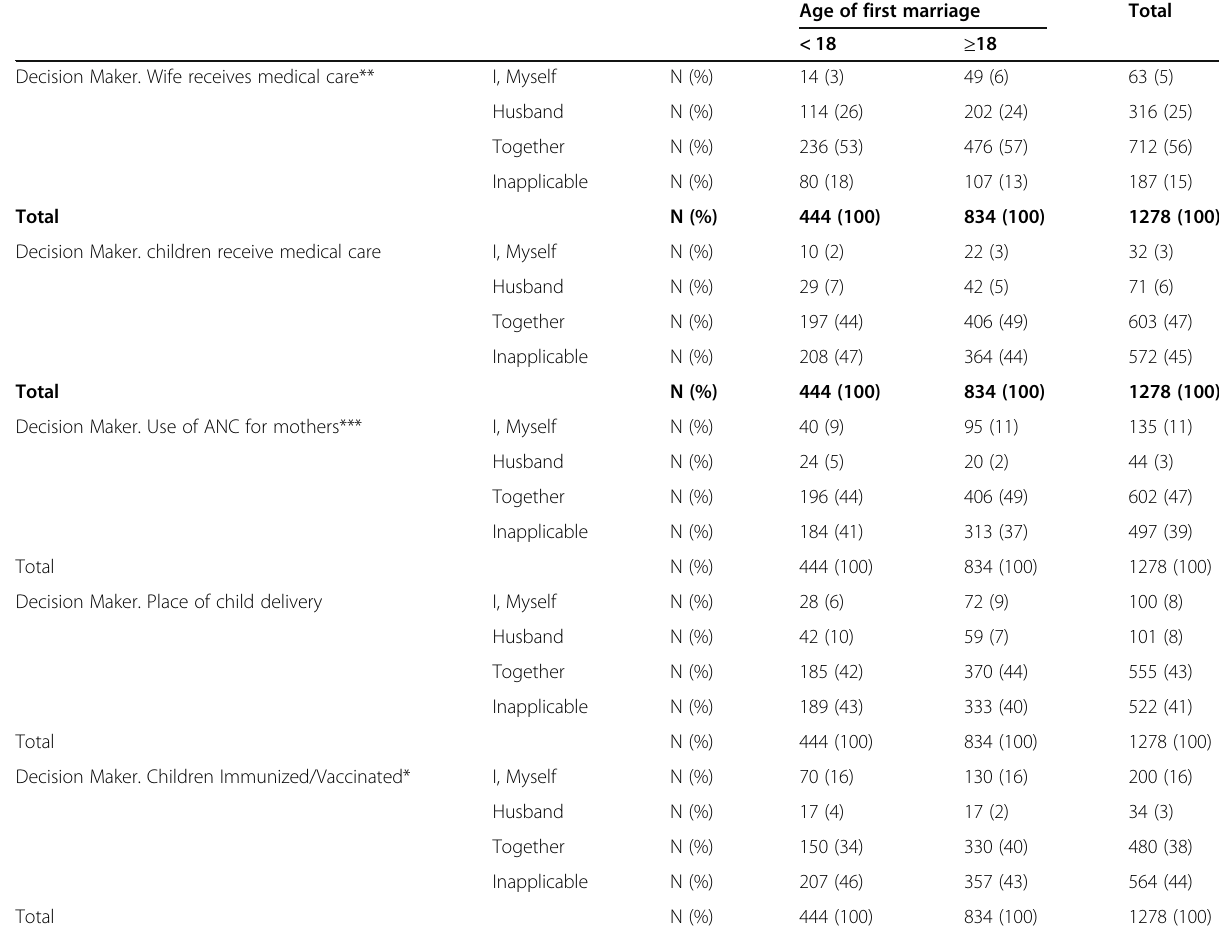
Age of first marriage